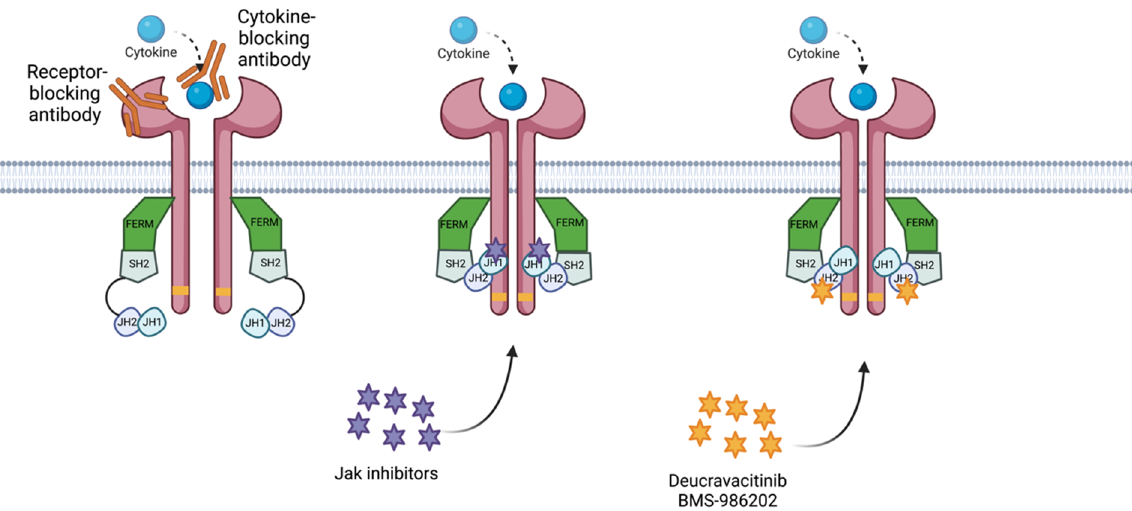
Figure 4. Diagram of mechanism of action for the treatments for IMIDs. The receptor-blocking antibody binds to the receptor, preventing its capacity to bind to the cytokine. The. cytokine-blocking antibody binds to the cytokine, blocking its capacity to bind to the receptor. Jak inhibitors bind to the JH1 domain—kinase domain—impeding adenosine triphosphate (ATP) binding to the JH1 catalytic domain. Deucravacitinib and BMS-986202 bind to the JH2 domain, locking the regulatory (JH2) domain into an inhibitory contact with the catalytic domain (JH1). Created with BioRen- der.com (accessed on 14 January 2023). Abbreviations: FERM, 4.1 ezrin, radixin moesin domain; SH2, Src-homology 2 domain; JH1, jak homology domain 1 (kinase domain); JH2, jak homology domain 2 (pseudokinase domain).